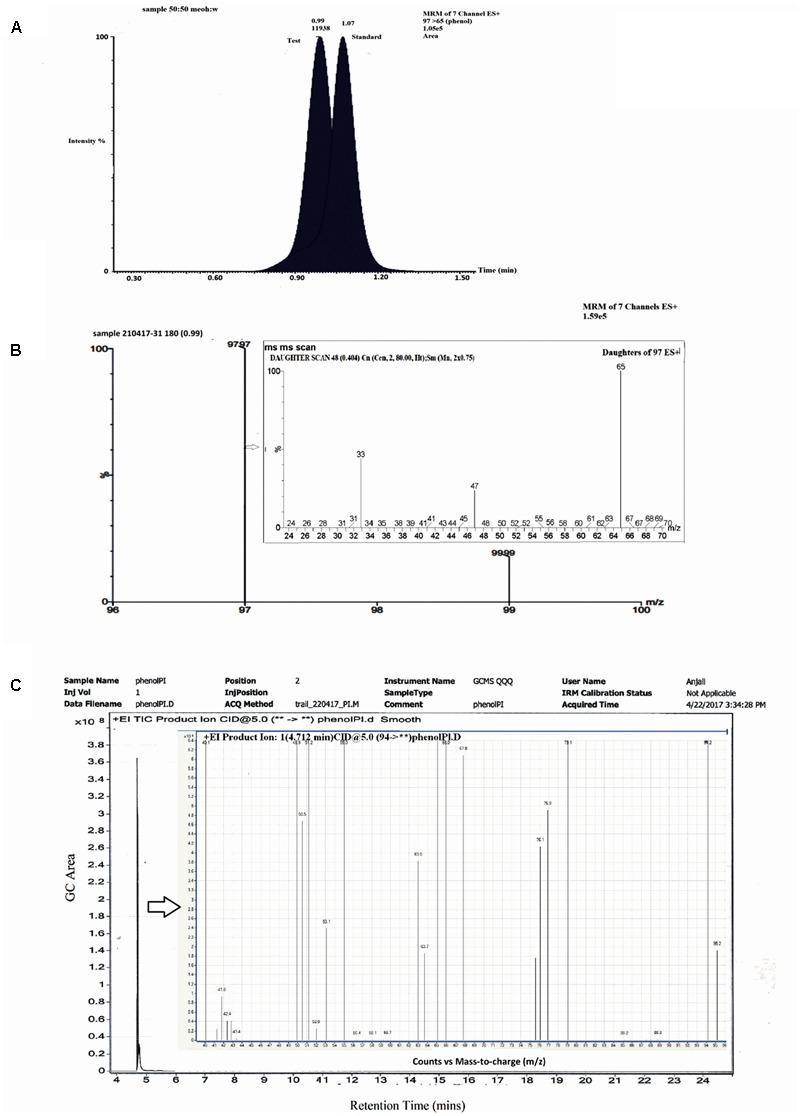
LCMS and GC–MS analysis of labeled water experiments. (A) Chromatographic profile of standard phenol and test sample. (B) MRM spectra of test sample showing two fragments at m/z 97 and 99. (B) Inset: MSMS spectra of test m/z 97. (C) GC profile of test sample showing a single peak at Rt 4.712 min. (C) Inset: Mass spectra of peak at 4.712 min.